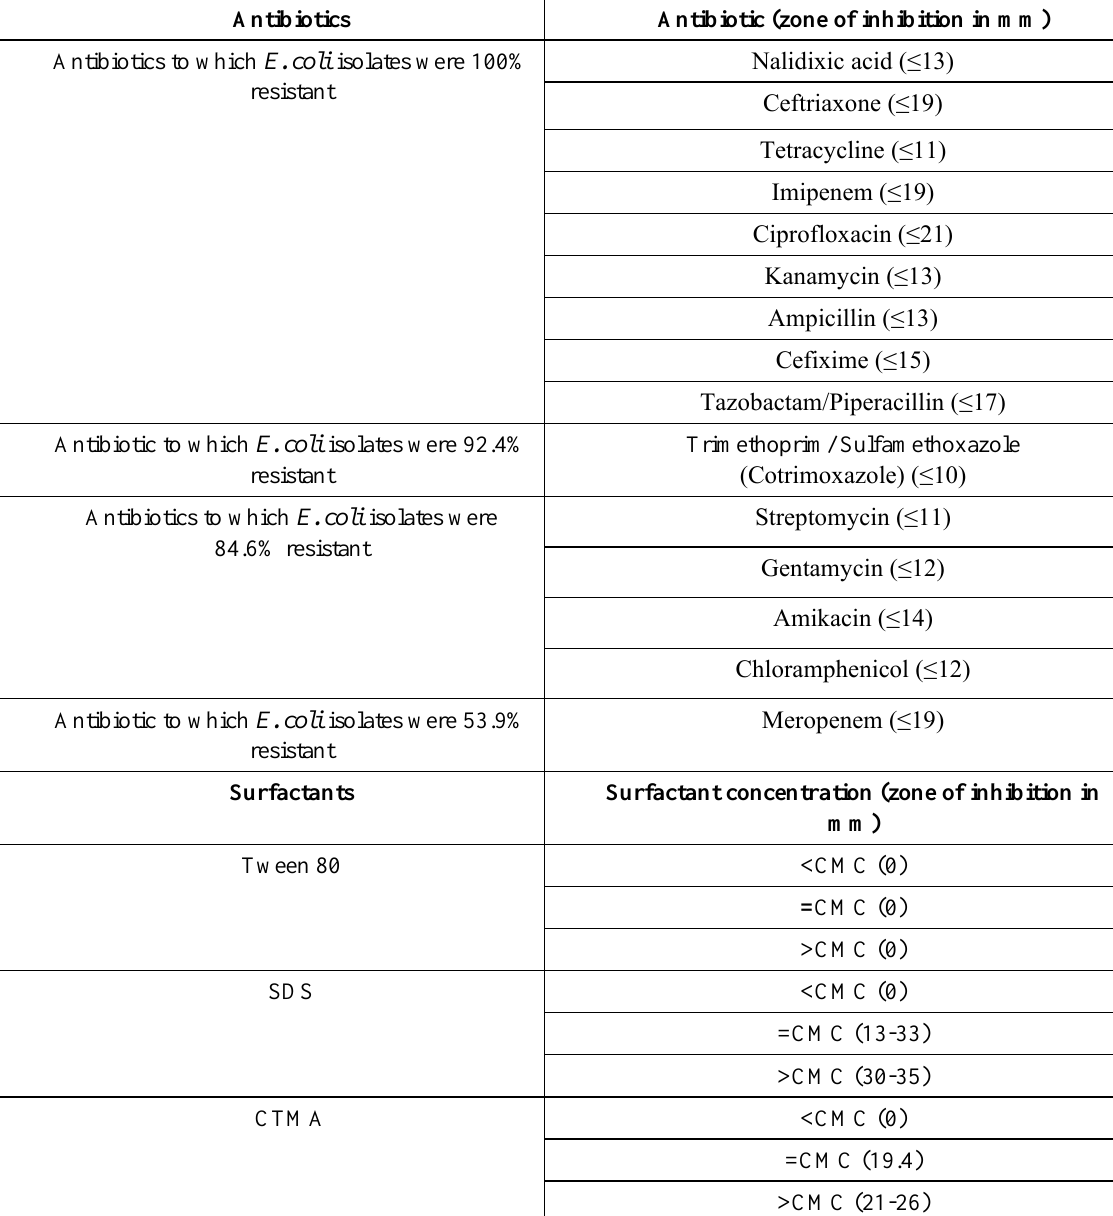
Table 2. In vitro susceptibility results of E. coli isolates to both commercially available antibiotic discs and